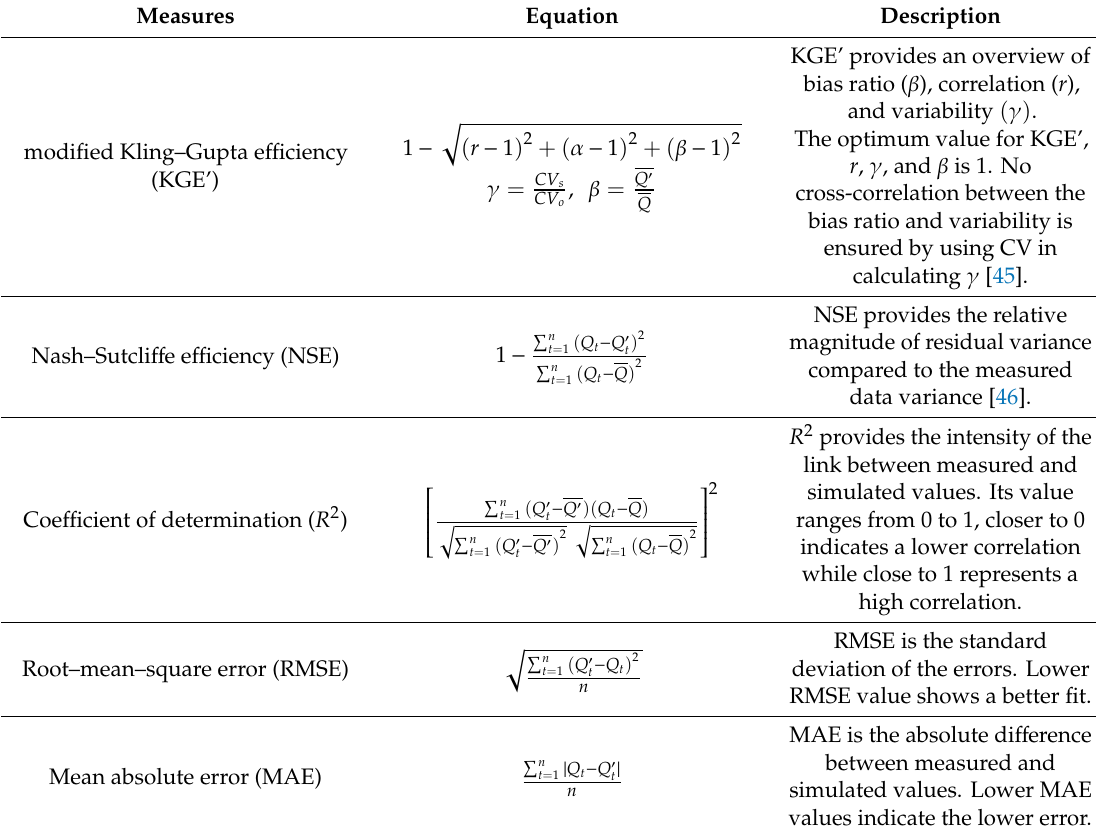
Table 1. Metrics used in the evaluation of